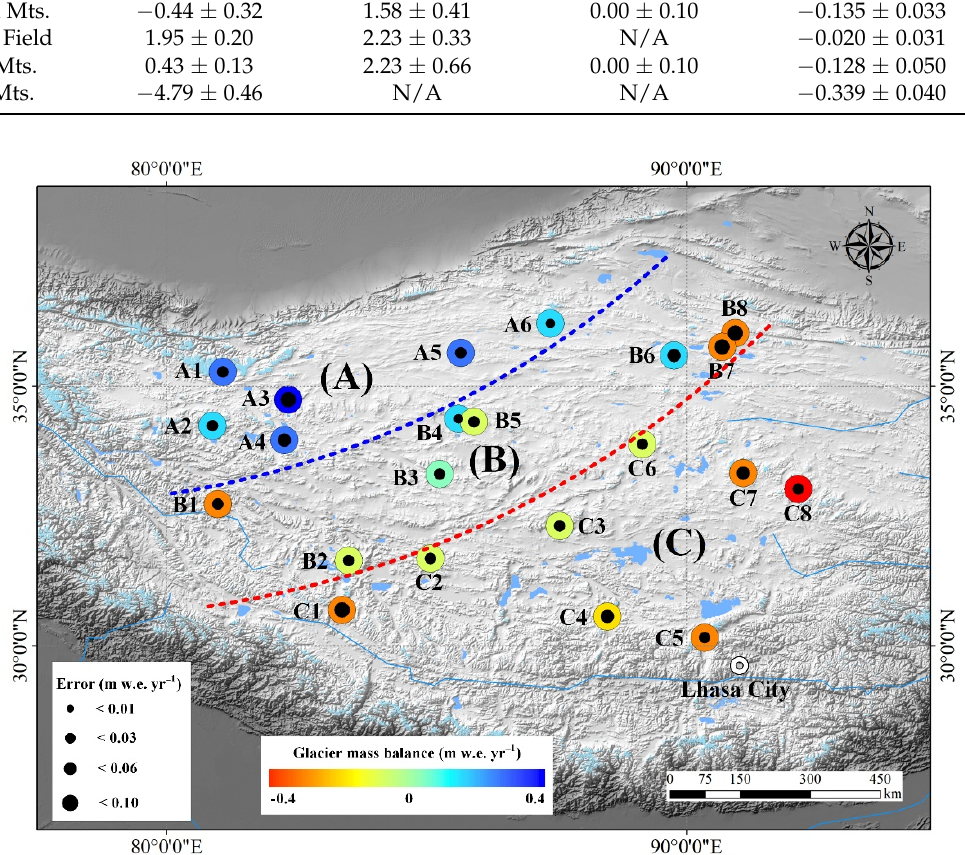
Figure 8. The estimated decade-average (2000–2012) glacier mass balance of the 22 study areas over the INTP. The blue and red dashed lines are used to divide the INTP into three sub-regions of zone A, B and C.